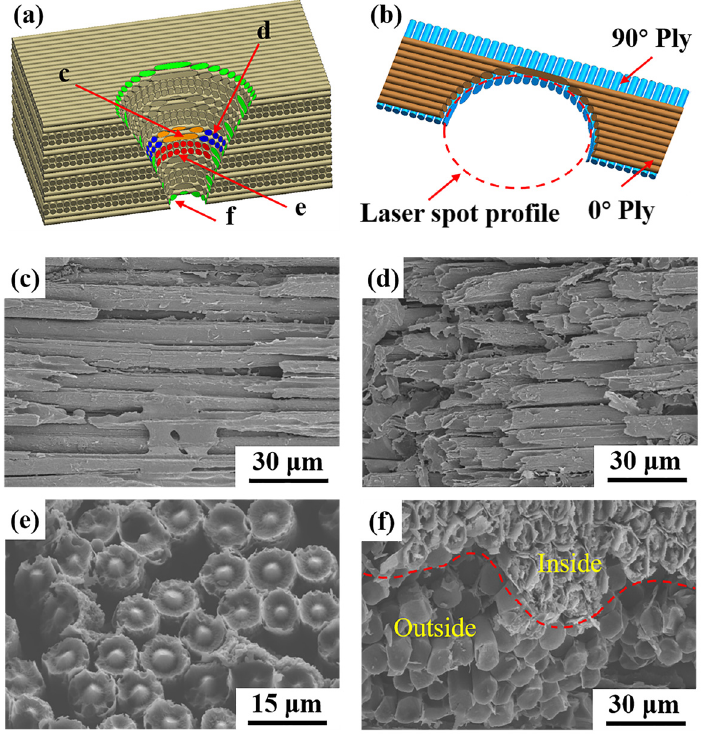
Figure 6. Ablation morphology of CFs in the ablation pit: ( a ) schematic for layup; ( b ) schematic for 0°/90° plies; SEM photograph for ( c ) center of 0° ply; ( d ) edge of 0° ply; ( e ) 90° ply; ( f ) edge of the ablation pit.